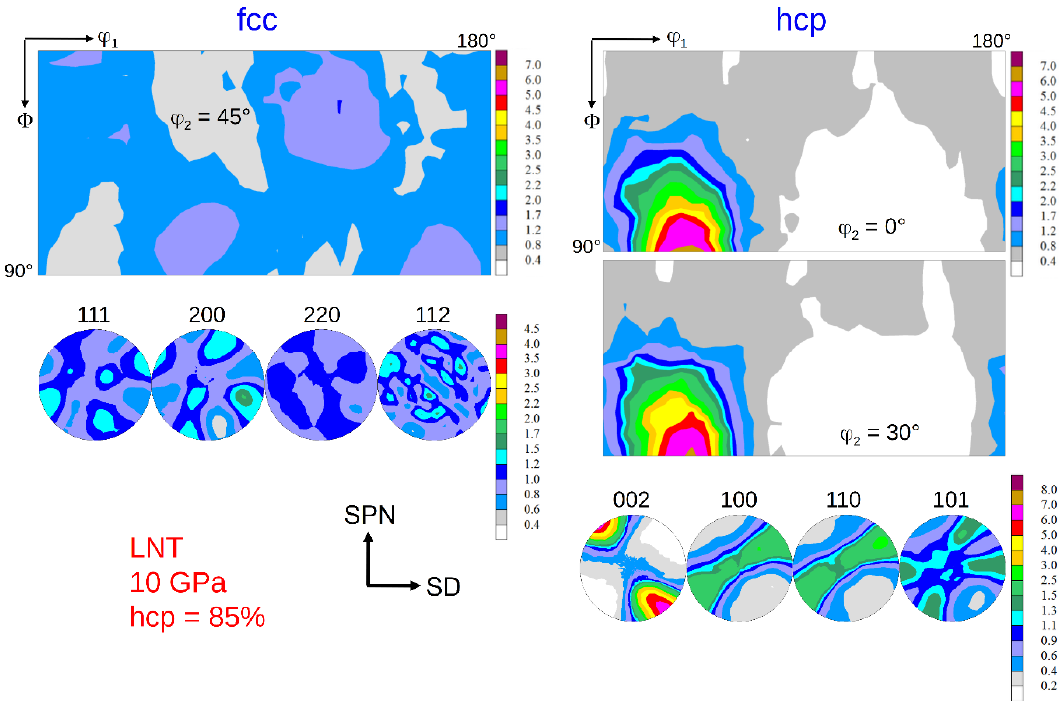
Figure 10. Texture of the fcc and hcp phase after HPT at LNT at 10 GPa pressure and a shear strain γ = 106 after 1 month storage at RT. The hcp volume fraction is 85%. (for key figures and designation of the fcc and hcp shear texture components see Figures 7 and 13 below, respectively).